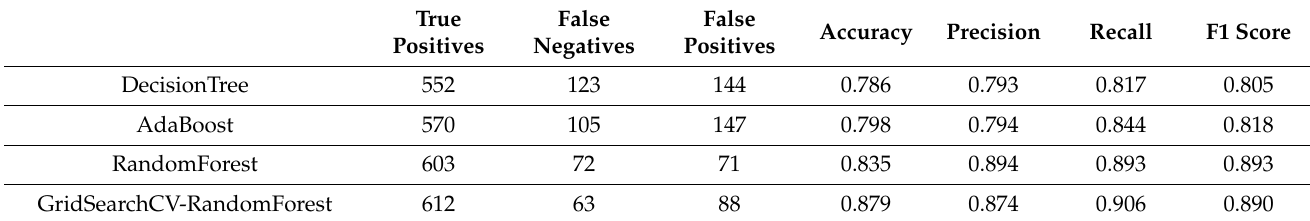
Table 9. Mote strain dataset.